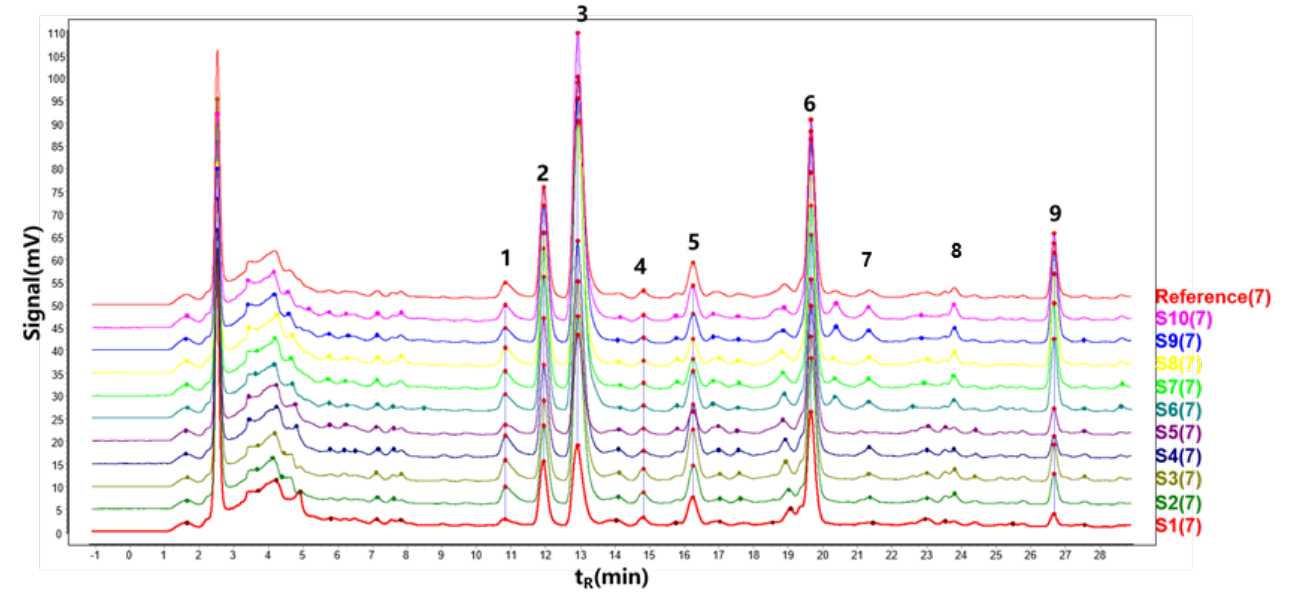
Figure 4. Reference fingerprint of Xiaochaihu capsule. Peaks 2, 3 and 5–9 were inferred to be ribitol, fructose, glucose, sucrose, maltose, raffinose, and stachyose,